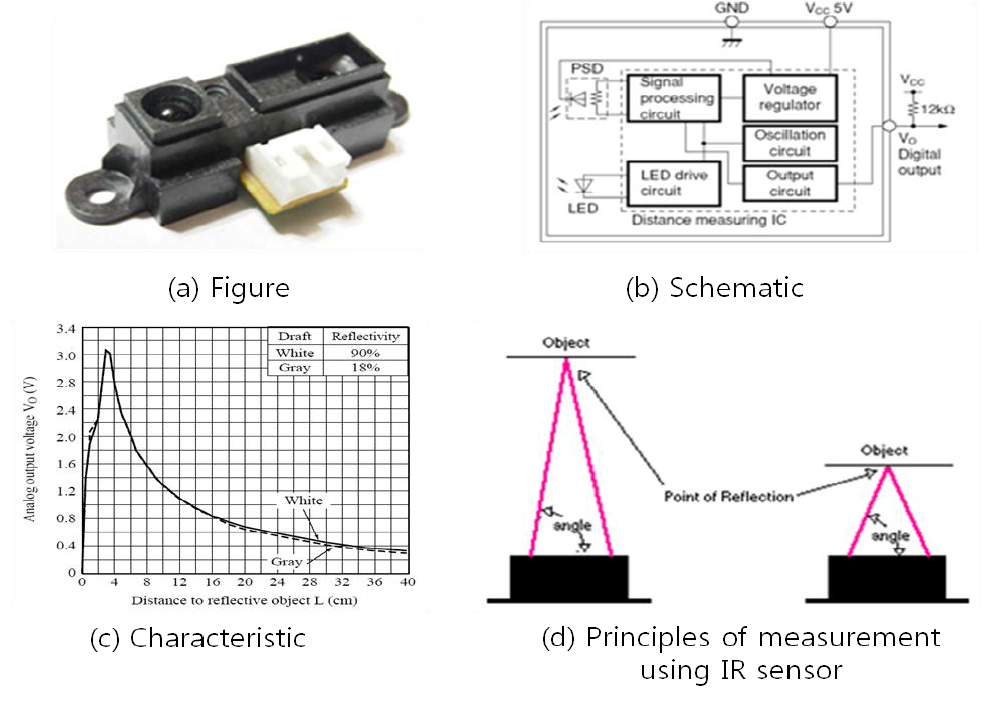
Figure 5. Infrared sensor used in this work (Model: SHARP GP2D120XJ00F Analog Output Type Short Distance Measuring Sensor).